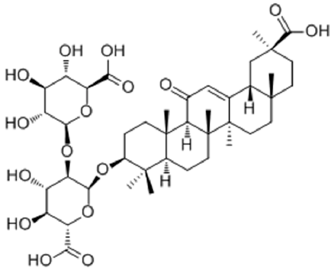
Figure 23. Structure of glycyrrhizin isolated from Glycyrrhiza glabra L.